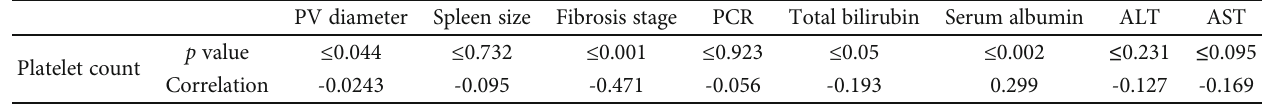
Table 5: Correlation between EOT platelet count and baseline imaging and laboratory data.